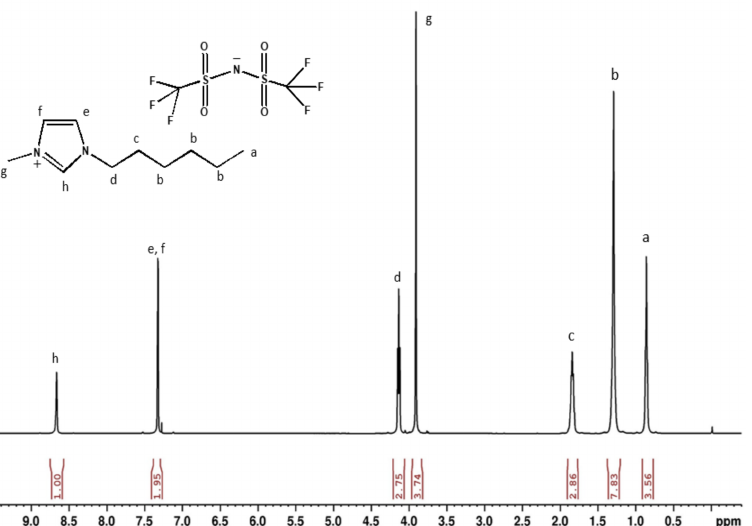
Figure 1. 1 H NMR spectrum of the as-received [HMIm][TFSI] dissolved in CDCl 3 . The molecular structures of TFSI ( top ) and HMIm ( bottom ) are shown in the top left corner. The a-to-h indexing of the peaks in the spectrum correspond to the markings on the molecular structure of